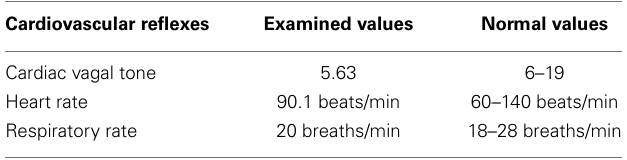
Table 2 | Growth parameters during second cycle of treatment . Table 3 | Cardiovascular reflexes range during cycles